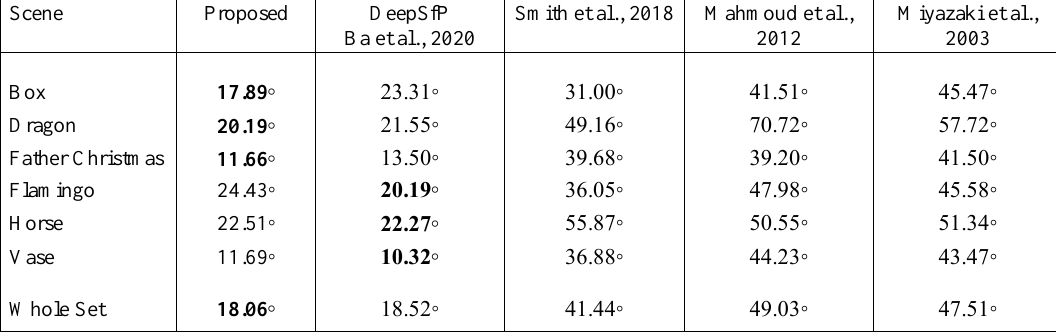
Table 1. MAE values of objects across the three different lighting conditions. Other results are collected from the official results in DeepSfP (Ba et al.,